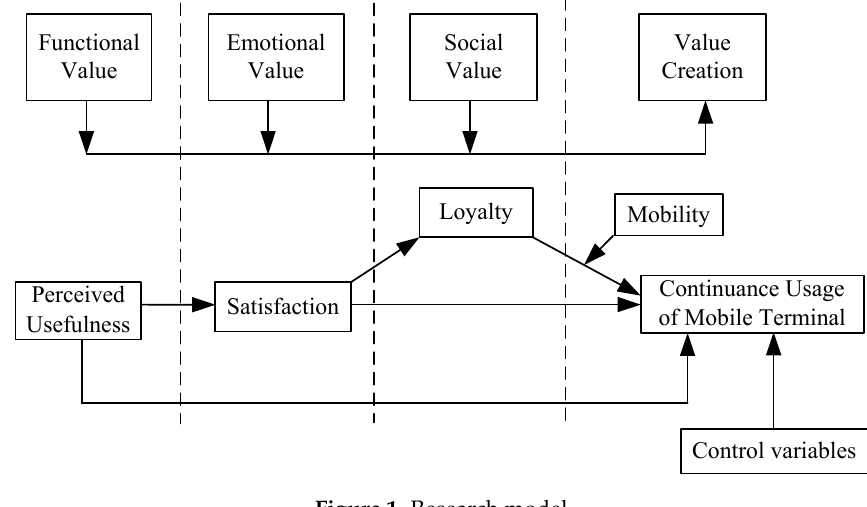
Figure 1. Research Figure 1. Research model.